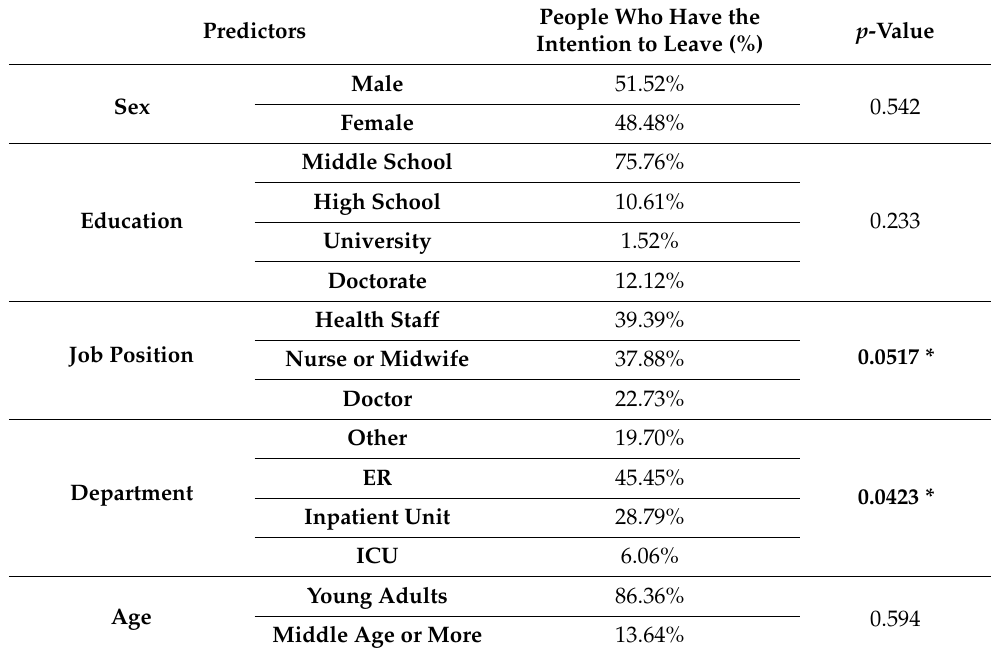
Table 2. Correlation between the demographic variables and the intention to leave.